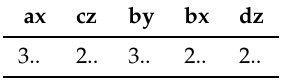
Table 7. MR-I results for absence constraints (activation).